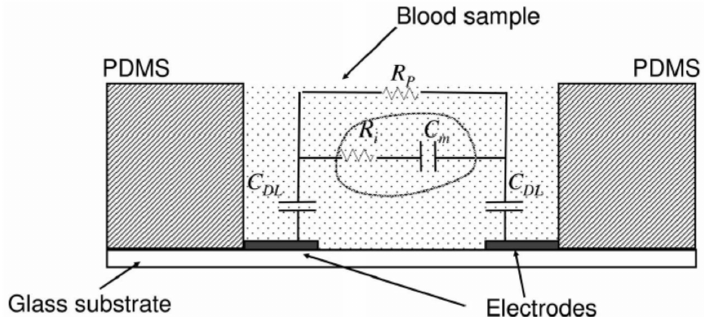
Figure 10. The equivalent electrical model of the whole blood, placed across two micro-electrodes embedded onto a PDMS micro-channel. (Reprinted with permission from ref. [72]. Copyright 2013 Lei et